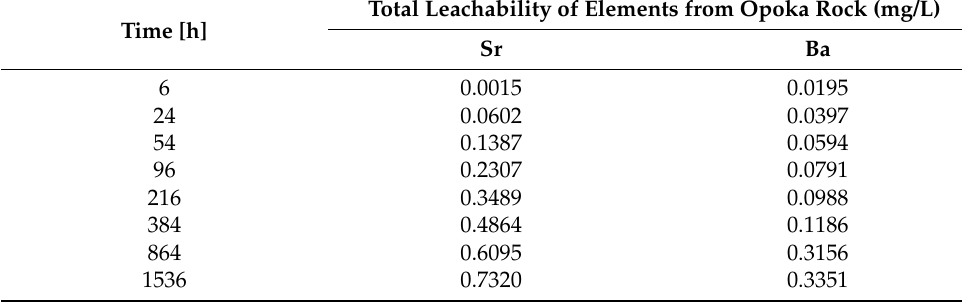
Table 3. Total leachability of elements from opoka